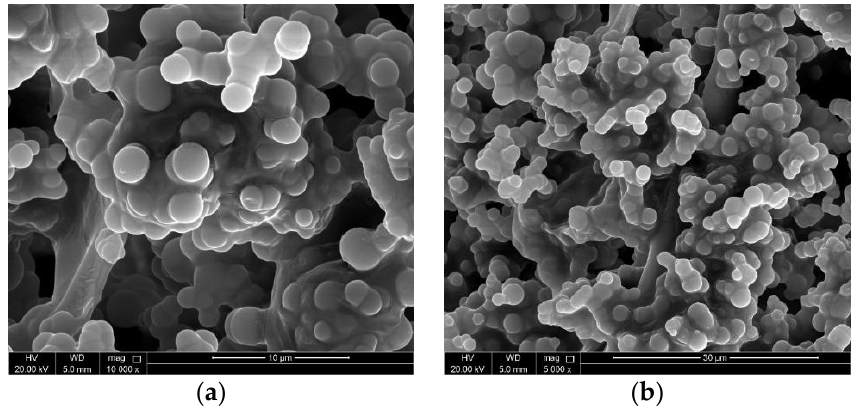
Figure 2. Trial-1 (0.25 g AOT) microcapsule SEM images for scales of ( a ) 10 µm and ( b ) 30 µm.